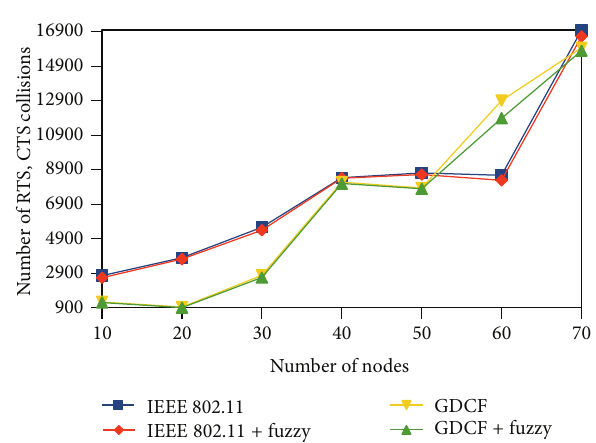
Figure 18: Number of collisions for varying traffic and nodes.